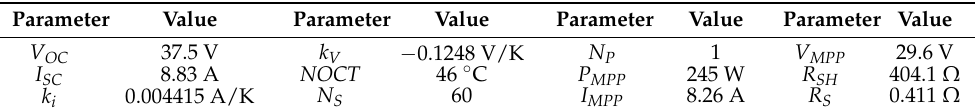
Table 1. Parameters of the PV module.